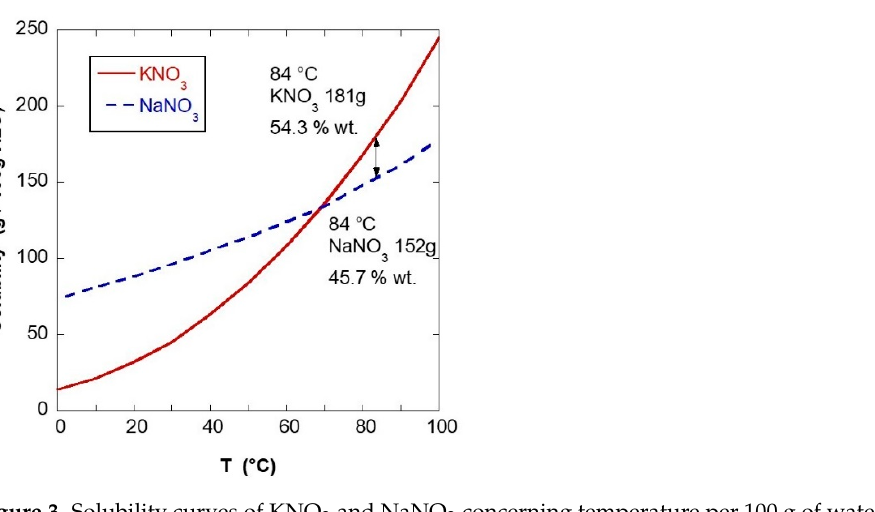
Figure 3. Solubility curves of KNO 3 and NaNO 3 concerning temperature per 100 g of water.